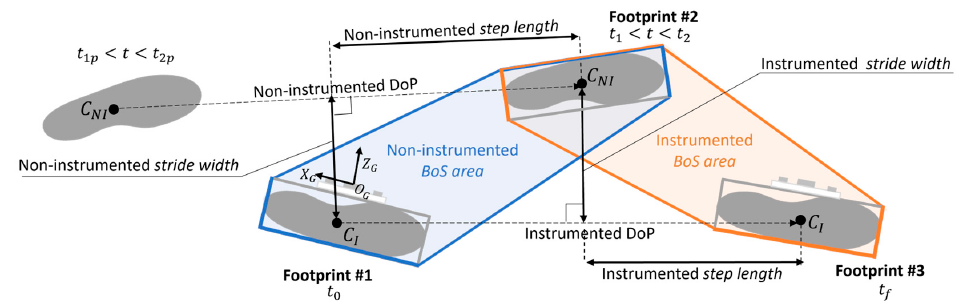
Figure 9. Definitions of base of support (BoS) parameters: BoS area, step length, and stride width. The black dots represent the feet centroids of the instrumented (C I ) and non-instrumented foot (C NI ). Dashed lines are the directions of progression (DoP) of instrumented and non-instrumented feet. Blue and orange lines de fi ne the outer edges of the instrumented and non-instrumented BoS areas, respectively. t 1p − t 2p and t 1 − t 2 are portions of two consecutive fl at-foot phases of the non-instru- mented foot. The global coordinate system CS G is taken as the reference system for all the BoS pa- rameters depicted.